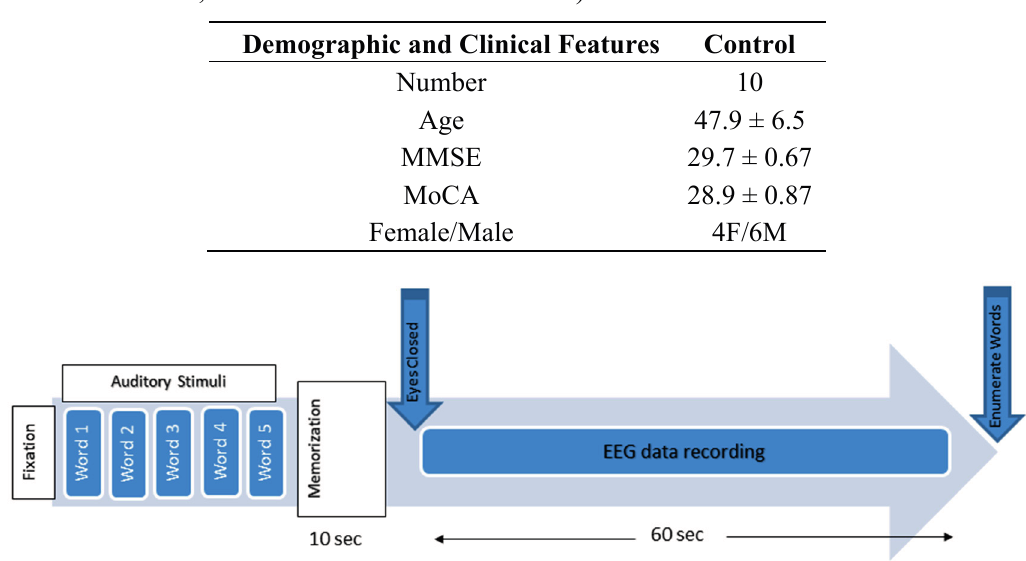
Table 1. Sociodemographic data of the control subjects. Mini-Mental State Examination (MMSE) and Montreal Cognitive Assessment (MoCA) scores are also shown, (Age in years, MMSE and MoCA, mean ± standard deviation SD).